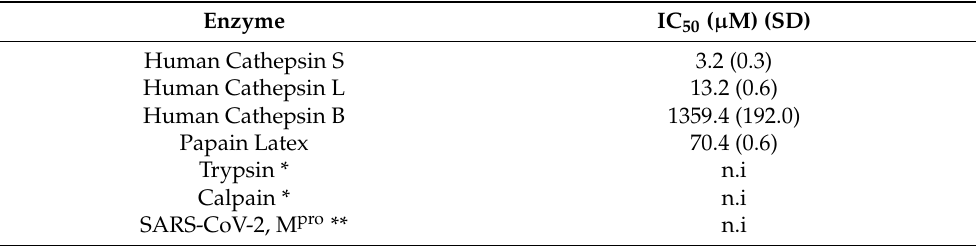
Table 3. Inhibition of several proteases by